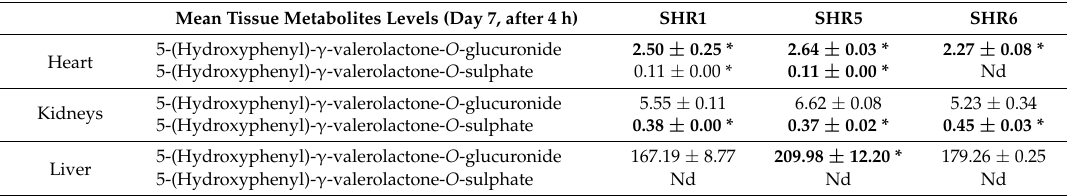
Table 7. Mean tissue metabolite levels at day 7, after 4 h of grape pomace extracts ingestion. Data are expressed as nmol per organ ± standard